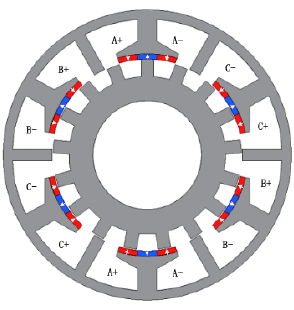
Figure 7. Topology of flux reversal motor with three-phase supply [64]. A, B and C represent the three-phase windings of the motor installed in an X configuration.